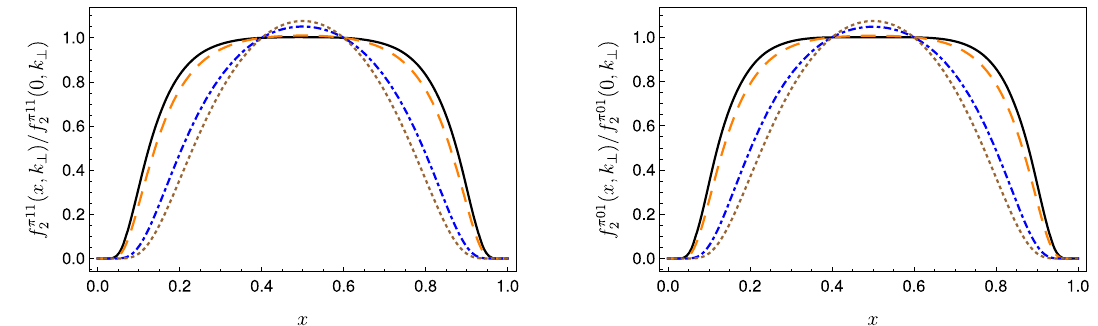
Fig. 5 The ratio r k ( x , k ⊥ ) , Eq. (7) evaluated for for different values of k ⊥ . Full black line k ⊥ = 0 GeV, dashed orange line k ⊥ = 0 . 2 GeV, dot-dashed blue line k ⊥ = 0 . 5 GeV and dotted brown line k ⊥ = 0 . 6 GeV. Left panel for the A = B = 1 configuration. Right panel for the A = 0 , B = 1